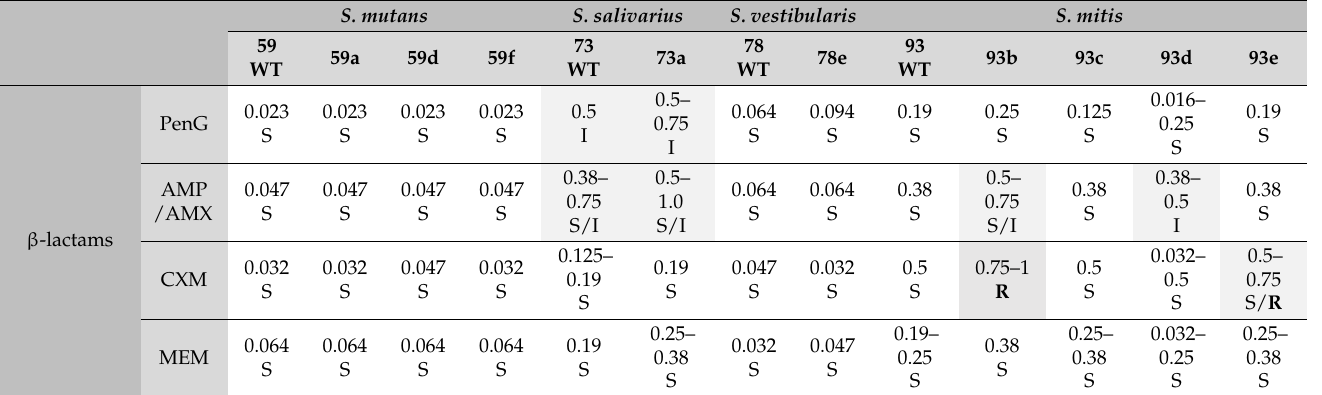
Table 4. Phenotypic antibiotic resistance of P10 replicates showing 8-fold MIC increase toward CHX and corresponding WT